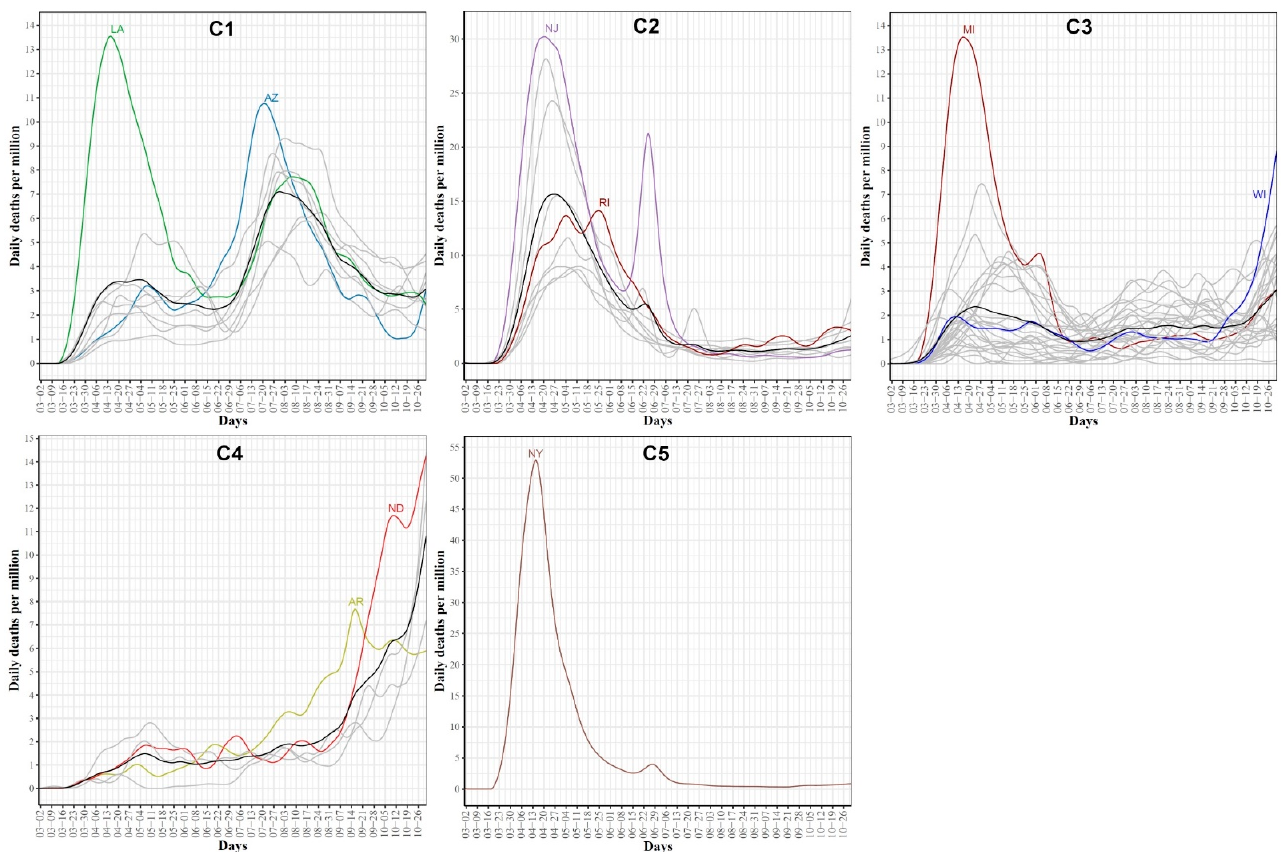
Figure 12. COVID-19 death trajectories of the states in each cluster. The mean curve for the states in each cluster is highlighted in black. Table 2. Characterization (in terms of median and rank) of the seven groups of COVID-19 death patterns across the 51 US states using four risk factors from 2019 US census data.